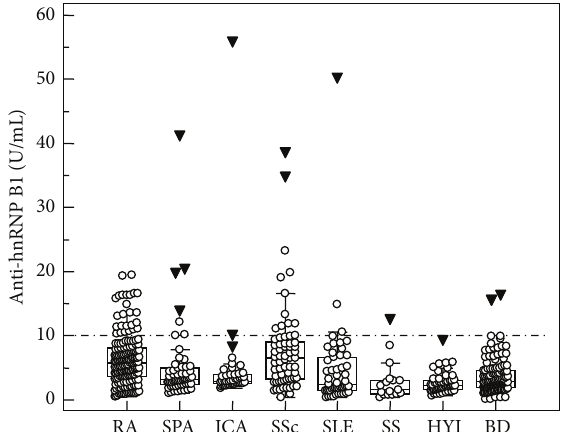
Figure 1: Anti-hnRNP B1 IgG levels in 165 patients (pts) with rheumatoid arthritis (RA), 58pts with spondyloarthropathy (SPA), 42 ptswithjuvenilechronicarthritis(JVA),65ptswithsystemicscle- rosis (SSc), 50 pts with systemic lupus erythematosus (SLE), 17pts with Sj¨ogren’s syndrome (SS), 52 controls with hyperlipidemia, and 112 blood donors (BD) detected by enzyme-linked immunosorbent assay (ELISA). (Data are displayed as U/mL in Box-and-Whisker plots with far-out values, defined as values that are smaller than the lower quartile minus 3 times the interquartile range or larger than the upper quartile plus 3 times the interquartile range, displayed as solid